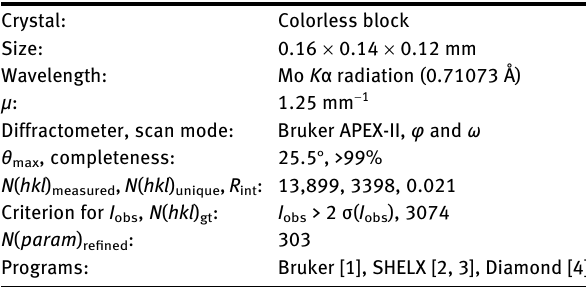
Table  : Data collection and